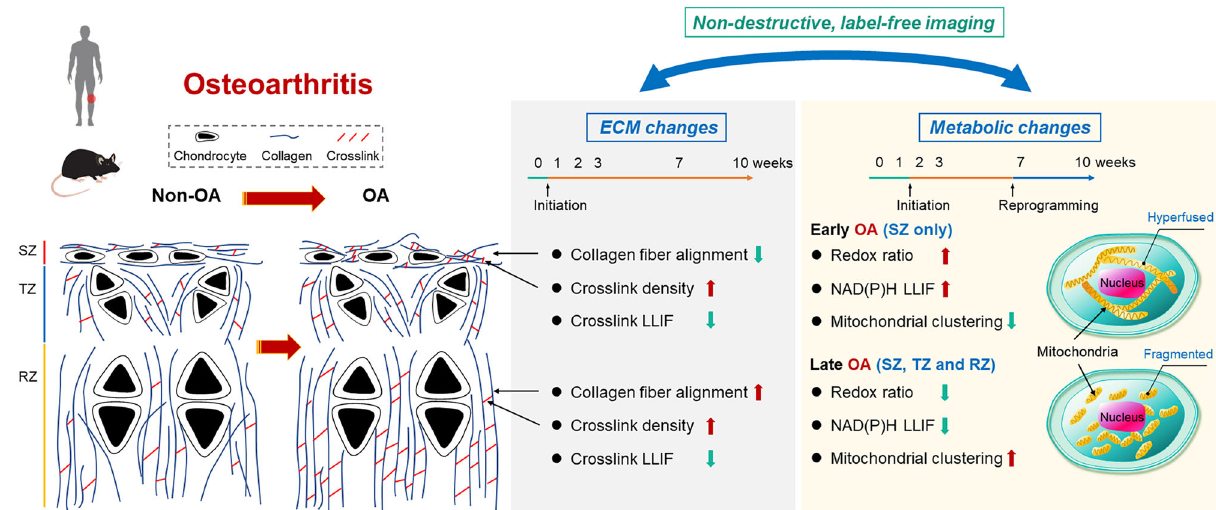
Fig. 7 Schematic of matrix and cell metabolic changes at early stages of osteoarthritis. SZ: Super fi cial zone; TZ: Transitional zone; RZ: Radial zone. This fi gure, including every element, is generated using Microsoft